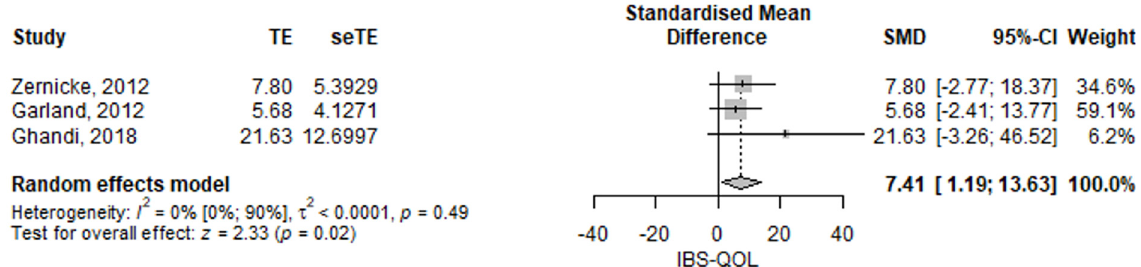
Figure 9. Irritable bowel syndrome quality of life at follow up,—standardized mean difference comparison between mindfulness intervention and control. IBS-QOL, irritable bowel syndrome quality of life; SMD, standardized mean difference; TE, treatment effect as SMD; seTE, standard error of the treatment effect; CI, confidence interval [15,17,20].